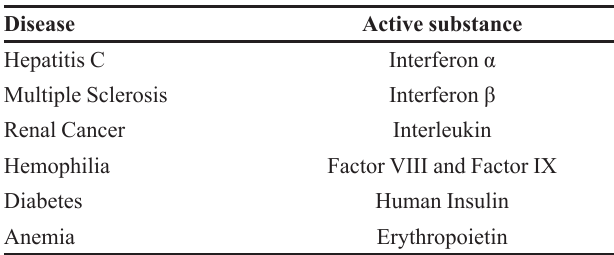
TABLE I – Some examples of diseases and